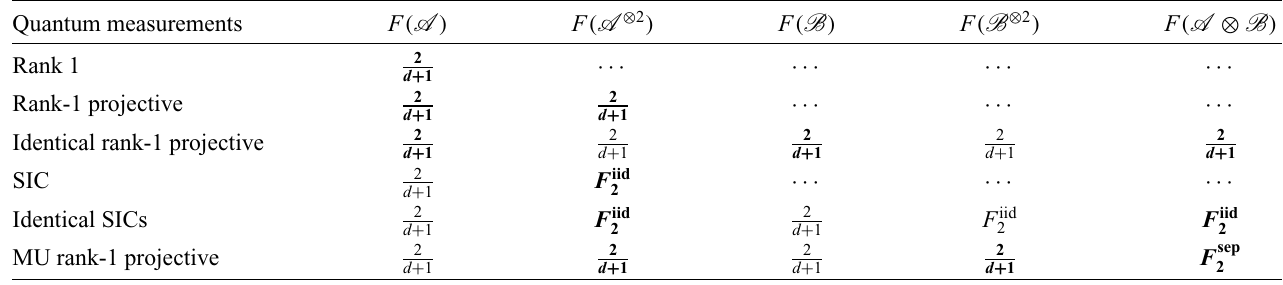
TABLE I. Operational characterizations of typical quantum measurements in terms of extremal one-copy and two-copy estimation fidelities. Each measurement (pair of measurements) in the left column is completely determined by the estimation fidelities in bold font in the corresponding row (at most three estimation fidelities are required in each case). Here A and B are POVMs on H ; F ( A ) and F ( B ) are one-copy estimation fidelities, while F ( A ⊗ 2 ) , F ( B ⊗ 2 ) , and F ( A ⊗ B ) are two-copy estimation fidelities. The estimation and F sep are defined in Eqs. (65) and (70), respectively. fidelities F iid 2 2 Quantum